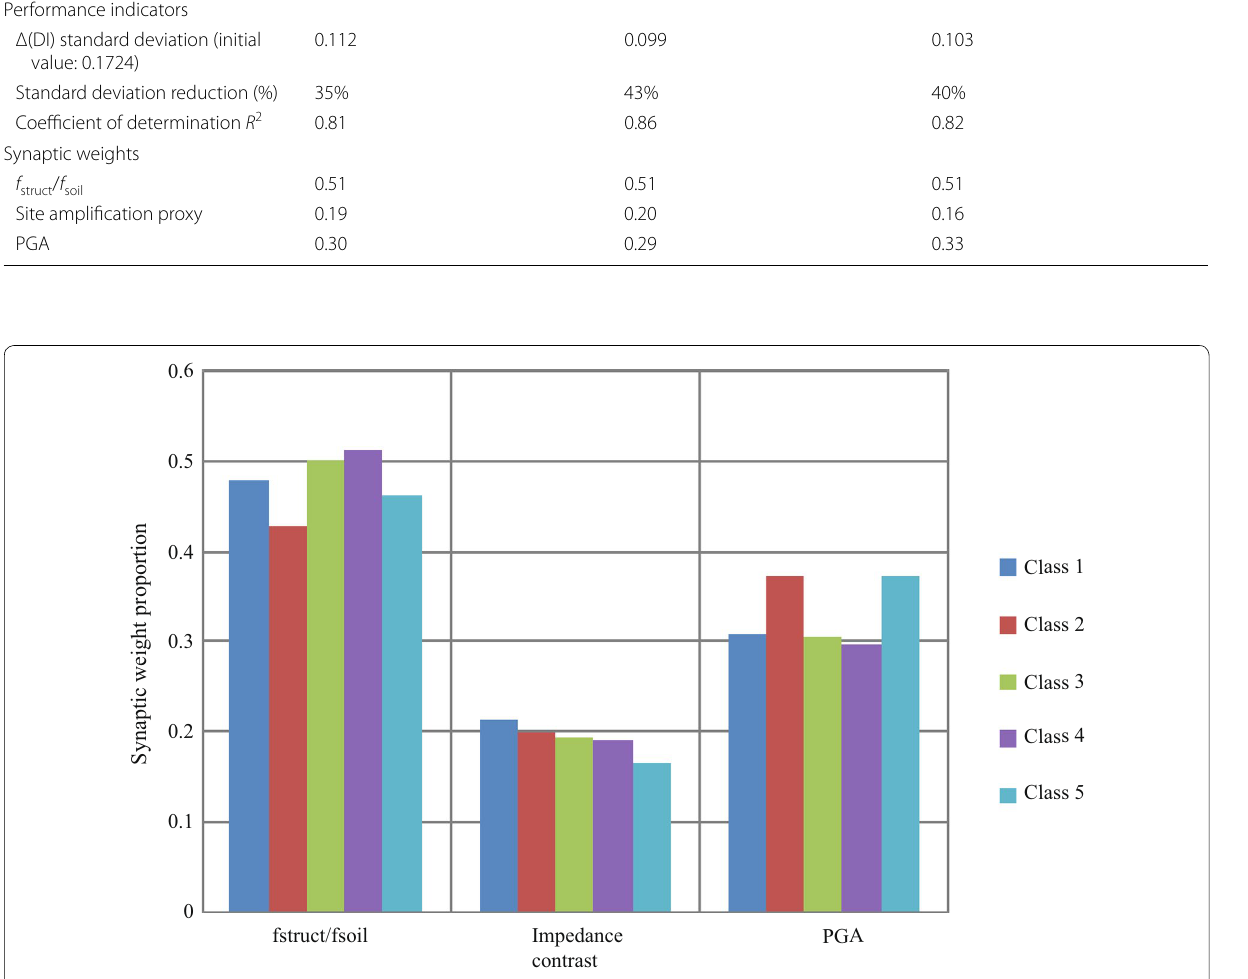
Fig. 4 Percentage of synaptic weights of the three inputs in the neural network approach (model 1): f struct / f soil , velocity contrast and PGA for the five typology classes as defined by Lagomarsino and Giovinazzi